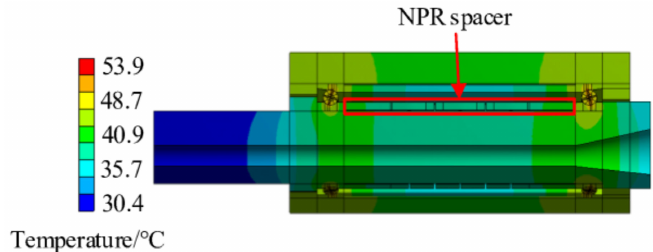
Figure 9. Spindle-bearing system temperature field at 8000 r/min.